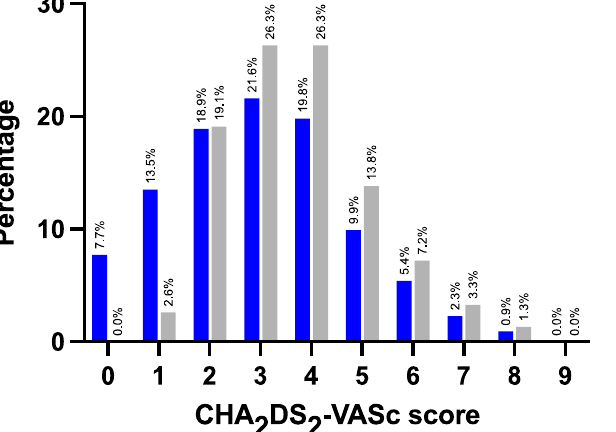
Figure 5. CHA 2 DS 2 ‐ VASc score values in AF patients from SEPHAR III and SEPHAR IV surveys. SEPHAR = Study for Evaluation of Prevalence of Hypertension and Cardiovascular Risk in an Adult Population in Romania.